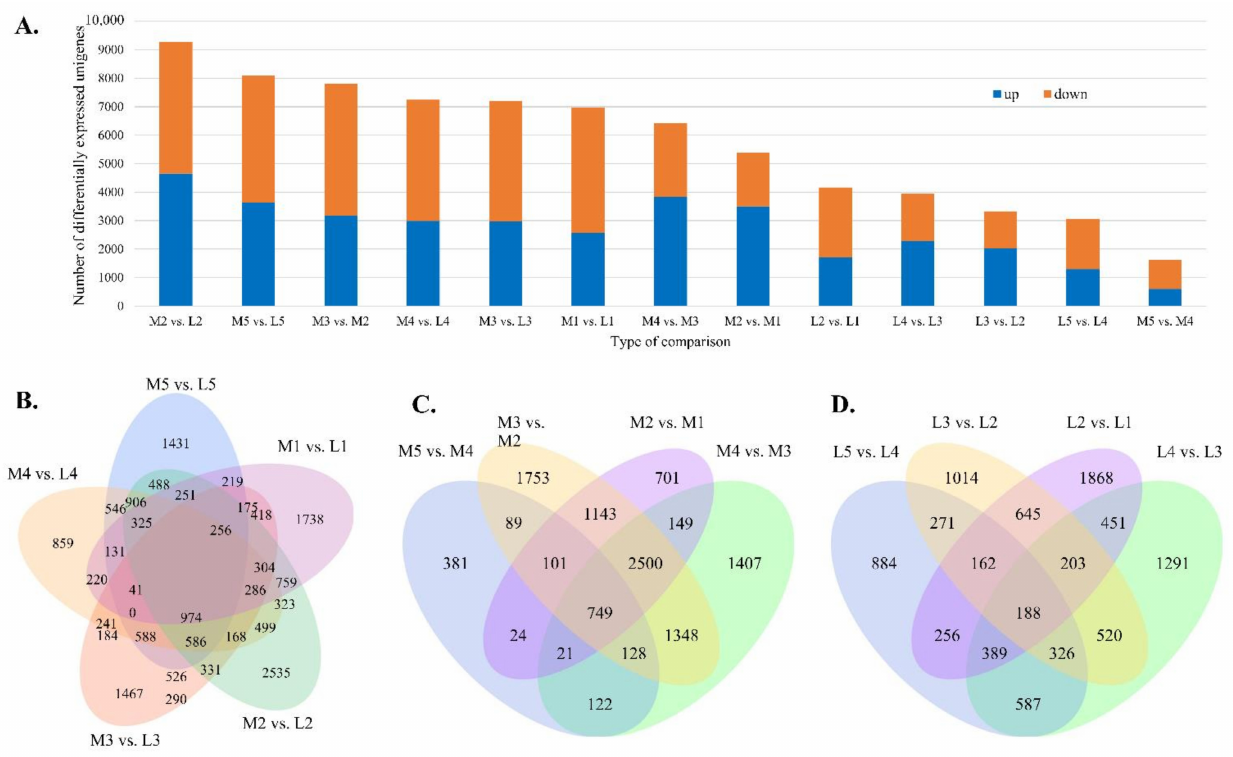
Figure 6. ( A ) Distribution of differentially expressed D. pectinatum unigenes identified in various comparisons. Venn diagram of differential genes in M vs. L ( B ), M vs. M ( C ), L vs. L ( D ). M: male reproductive tissue; L: leaf. 1: 8 April, 2: 10 May, 3: 3 June, 4: 3 July, 5: 11 November.